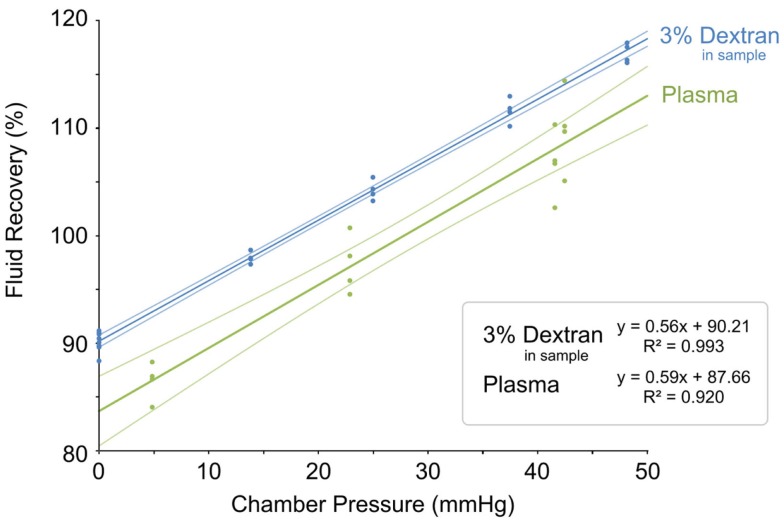
Fluid recovery plotted as a function of external sample pressure. In vitro MD test fluid recovery plotted as a function of external sample pressure in dextran sample (blue) and plasma sample (green) (42). Reprinted with permission from Chu (42). Copyright 2014 Springer Science Media.